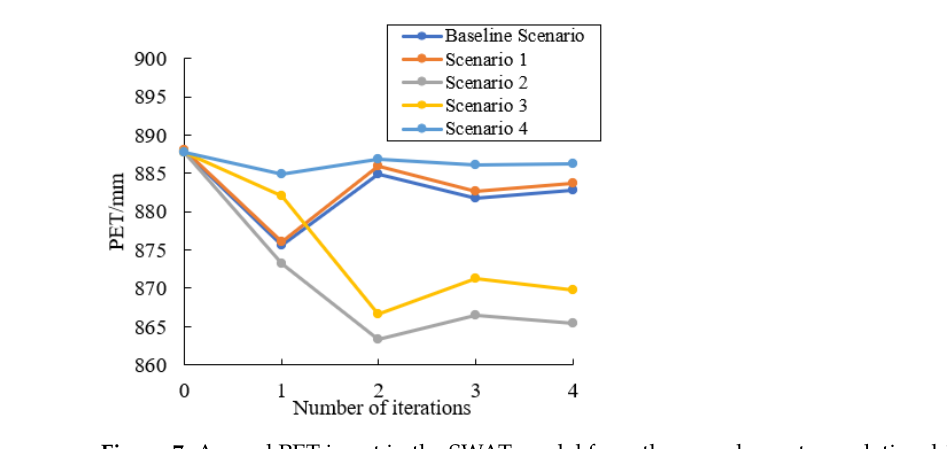
Figure 7. Annual PET input in the SWAT model from the complementary relationship in different scenarios.